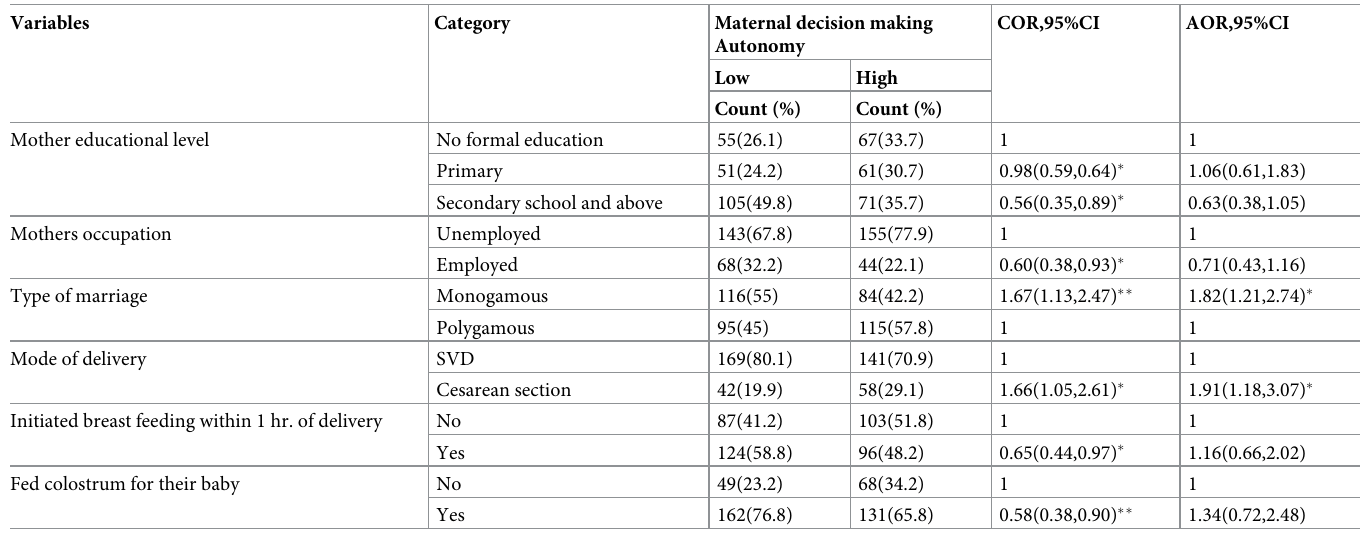
Table 5. Factors associated with decision-making autonomy among postpartum mothers in Shashamane town, Oromia, Ethiopia,